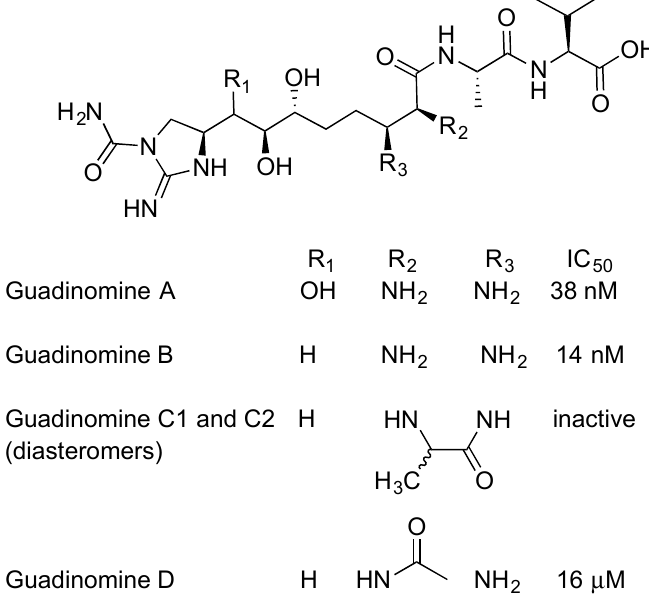
Figure 6. Analogs of cytosporone B (Csn-B) synthesized and analyzed for T3SS inhibitory activity by the Shen group.